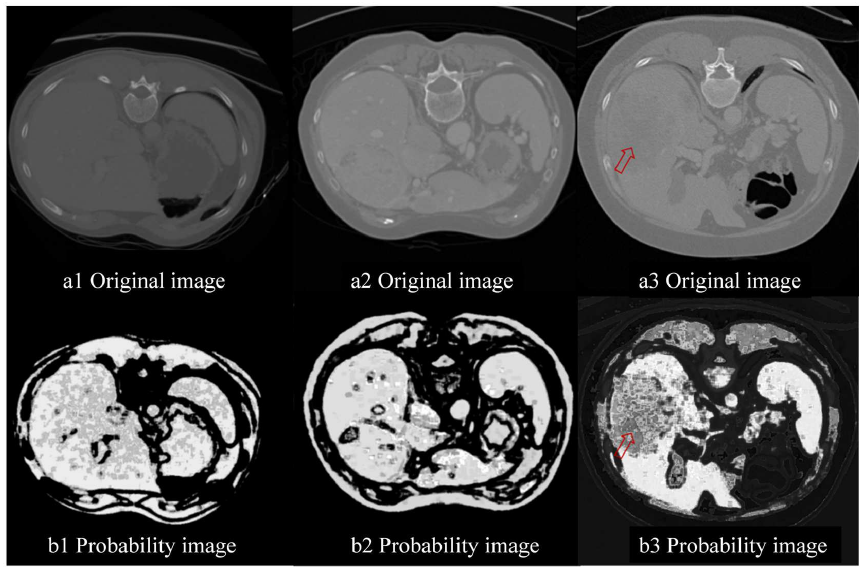
Fig 6. Probability